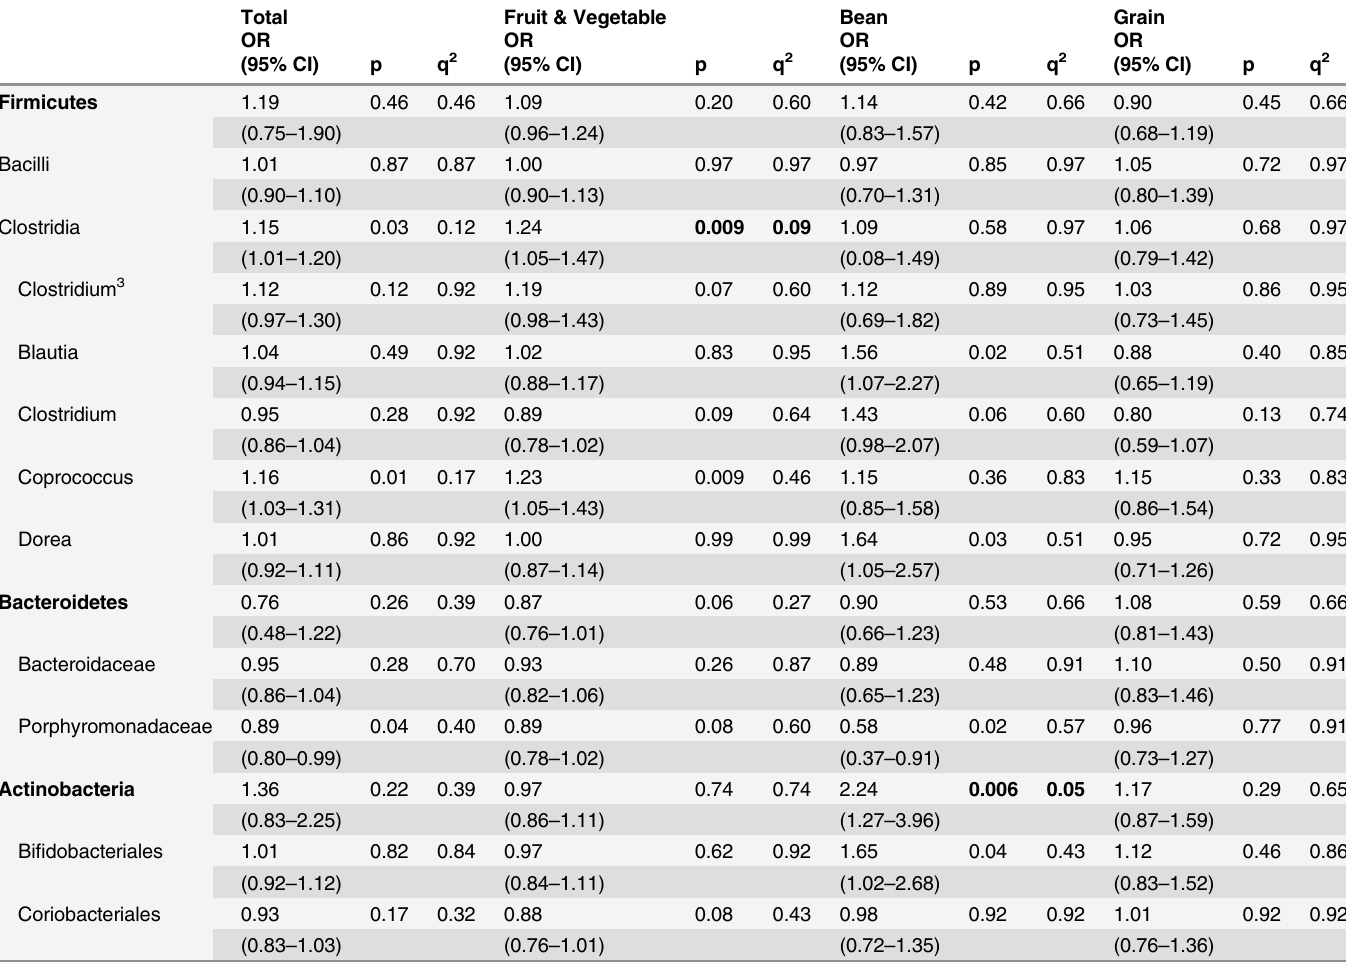
Table 4. Odds Ratio 1 of having higher relative abundances of taxa by total and specific fiber